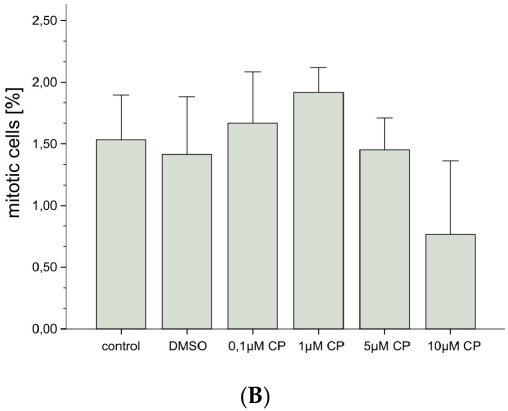
Figure 2. ( A ) Frequencies of apoptotic and necrotic cells and ( B ) frequencies of mitotic cells in primary pneumocyte cultures incubated with different concentrations of CPs; *: p < 0.05 compared to the DMSO control; N = 3.